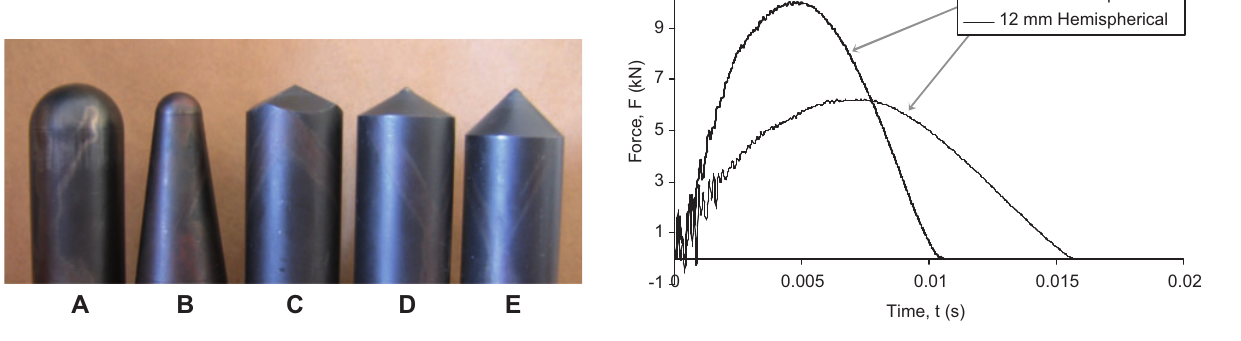
Figure 2 (A) 24 mm hemispherical, (B) 12 mm hemispherical, (C) pyramidal, (D) 120 ° conical and (E) 90 ° conical impactors.